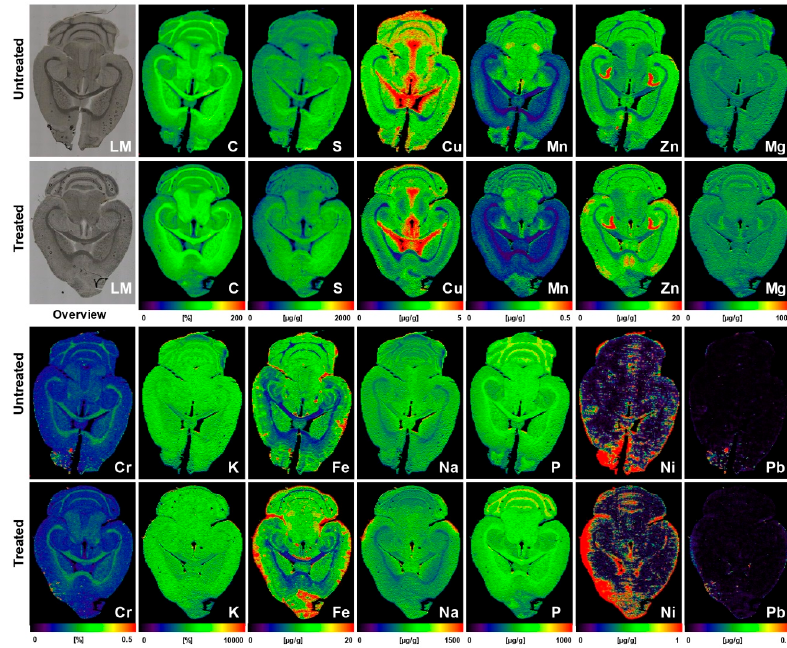
Figure 8. Gene therapy in Atp7b null mice reverses cerebral Cu overload. The content of carbon (C), sulfur (S), copper (Cu), manganese (Mn), zinc (Zn), magnesium (Mg), chromium (Cr), potassium (K), iron (Fe), sodium (Na), phosphorus (P), nickel (Ni), and lead (Pb) was imaged by LA-ICP-MSI in 30-µm-thick brain cryosections of Atp7b null mice that received a therapeutic effective AAV virus expressing a therapeutically effective human ATP7B gene. Control samples were taken from untreated age-matched Atp7b null littermates. For orientation, light microscopic (LM) images of respective cryosections before subjecting to LA-ICP-MSI procedure are depicted. Details on the applied AAV vector system used in this therapeutic approach are given elsewhere [44,49]. X-ray fluorescence (SXRF) imaging, were also shown to be beneficial in imaging of copper and other elements in the liver, brain, and intestine of normal and Wilson disease mice. In a previous SXRF